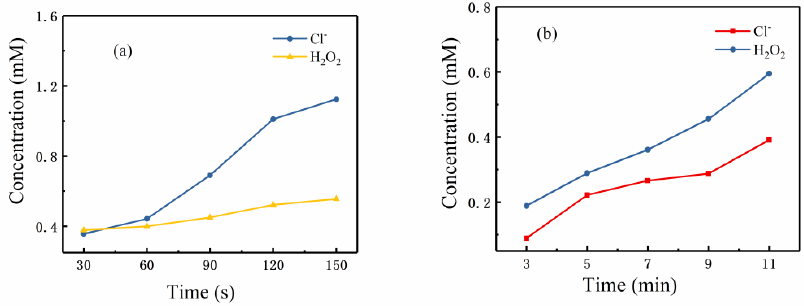
Figure 12. Cl − and H 2 O 2 generation in the ( a ) A-Jet and ( b ) P-Jet cases.